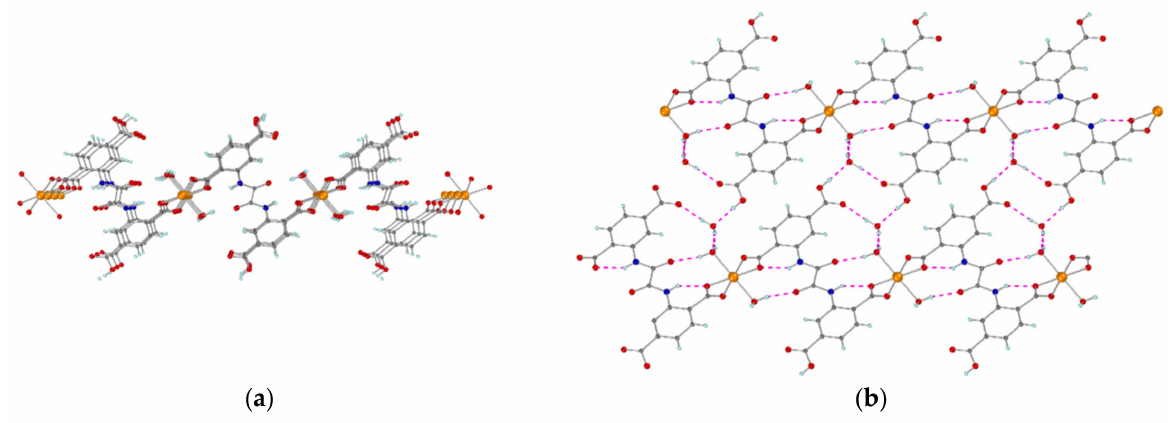
Figure 3. Two views of the 2D framework of 2D-Fe-MOF . ( a ) A single layer down to the b axis and ( b ) two neighboring layers down to b axis showing the intra- and inter-layer hydrogen bonding (purple dashed lines). Color code: Fe orange, C, grey, H cyan, O red, N